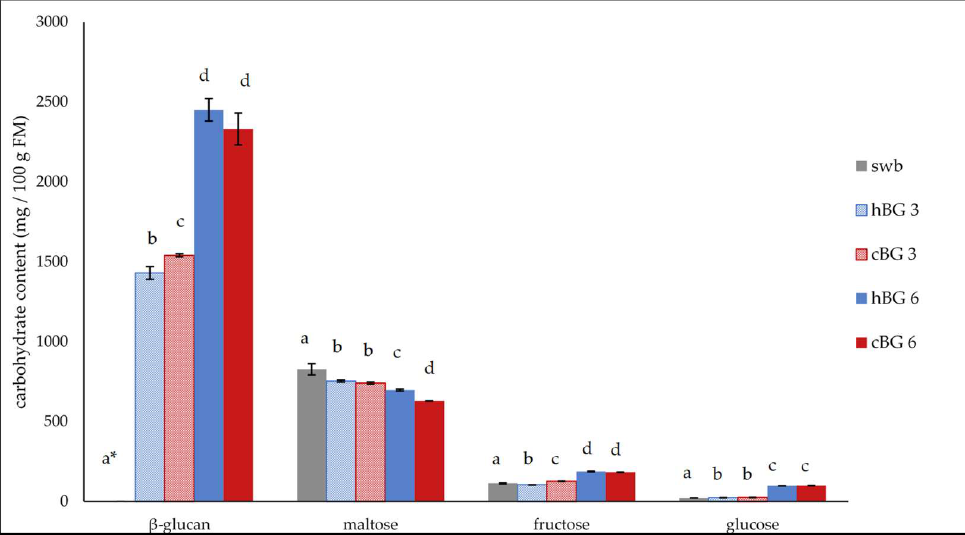
Figure 3. Contents of relevant carbohydrates in standard wheat bread (swb) and in breads fortified with 3% of high molar mass β-glucan (BG) or control BG (hBG 3 or cBG 3) and 6% of high molar mass BG or control BG (hBG 6 or cBG 6 in mg/100 g fresh matter (FM). All values are shown as mean ± standard deviation ( n = 3, p < 0.05). Different lower-case letters indicate a significant difference between the breads regarding each carbohydrate. * BG content was below the limit of quantification of 0.25% and hence, set as “zero”.